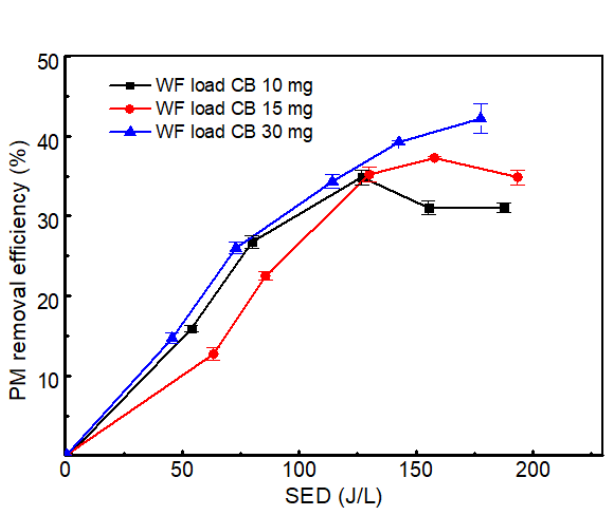
Figure 5. PM incineration at wood fiber loaded carbon black 10, 15 and 30 mg (error bars indicate the standard deviation).